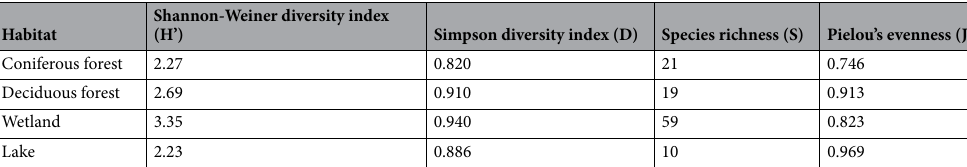
Table 1. Diversity, richness, and evenness indices for the drone collection of the four habitats.